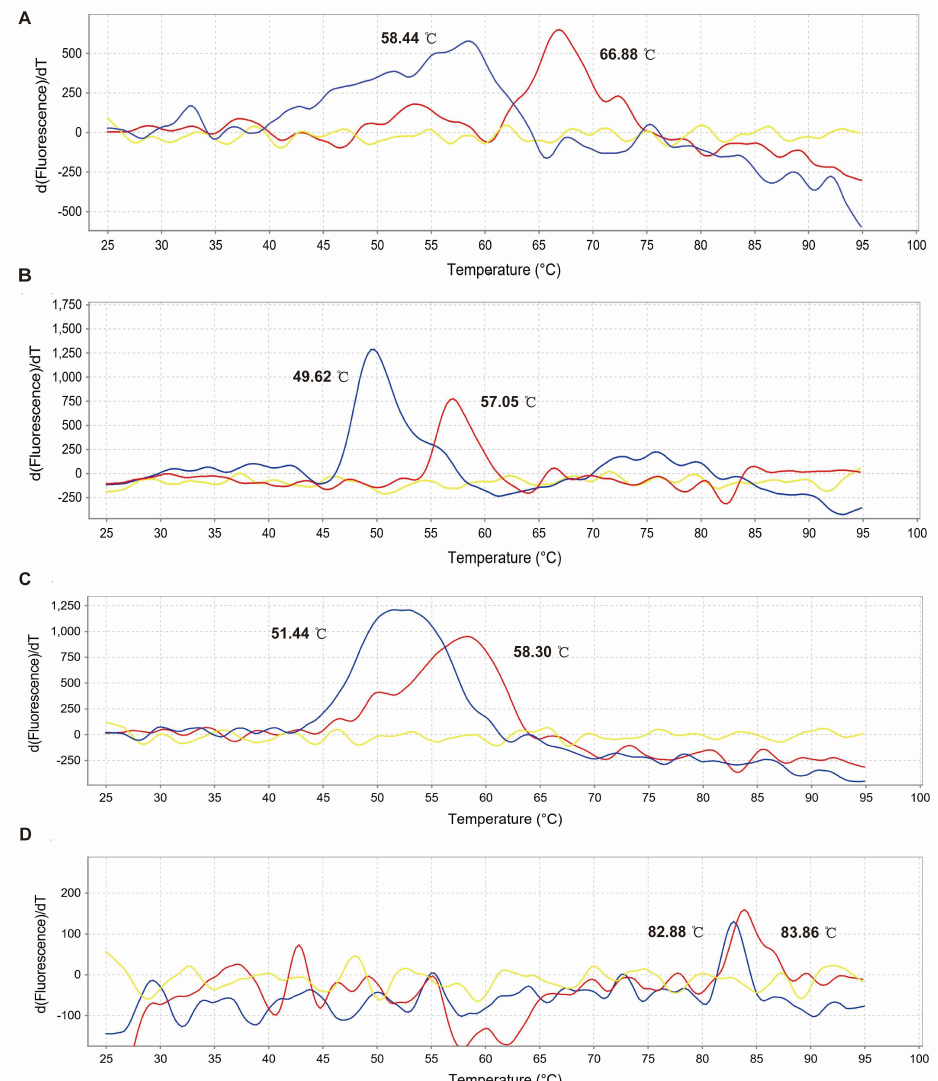
Figure 2. Thermal shift analysis of protein stability and ligand interactions. ( A ): Artemisinine (Tm). ( B ): Daidzein (Tm). ( C ): Curcumin (Tm). ( D ): Apigenin (Tm). The blue curves represent NS5B in the absence of no ligand, the red curves represent NS5B in the presence of Chinese medicine monomer, and the yellow curves are controls.